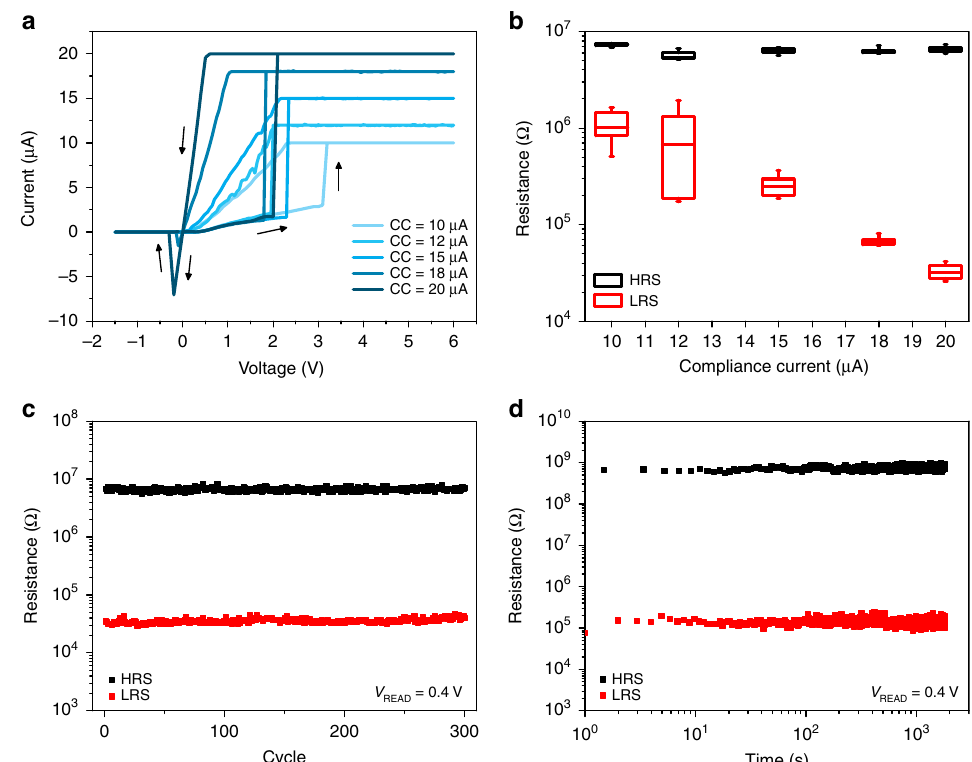
Fig. 4 DC operation modes of a single ZnO NW exhibiting multilevel memory capability. a I – V curves obtained by quasi-static DC voltage sweeps for different applied CC, showing bipolar resistive switching behaviour. b Measured LRS and HRS resistance values (read at 0.4 V) showing multilevel memory capability through the modulation of the programming current. Box plots were obtained from 15 consecutive cycles for each value of imposed CC on the same device. Midline represent median value, boxes the 25th and 75th percentiles and whiskers the 10th and 90th percentiles. c Endurance properties of the device acquired by full-sweep cycles with a programming current of 20 µ A and d retention properties of a NW-based device after being switched to the LRS and